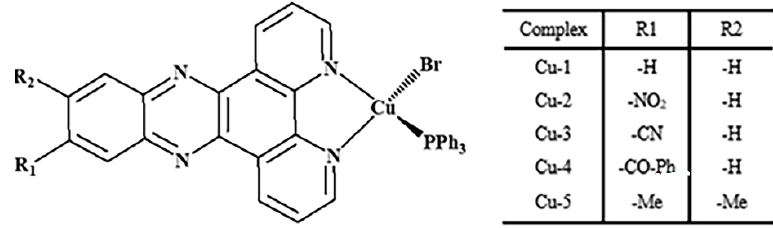
Figure 2. Copper(I) complexes studied in this work.